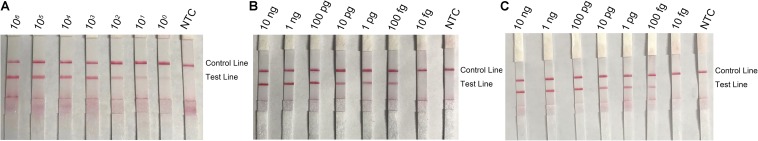
Detection limit of the RPA–LFS system. (A) The image shows the LFS results of RPA amplifications with different amounts of L. monocytogenes culture. The amounts (in CFU) added to the RPA reactions are indicated on top of each strip. (B,C) Images of the LFS results of RPA amplifications with different amounts of L. monocytogenes genomic DNA. The amounts added to the RPA reactions are indicated on top of each strip. In panel C, 10 ng of the genomic DNA of B. cereus was added to the reactions in addition to the L. monocytogenes genomic DNA. The NTC strips are the no-template controls. The reactions were performed at 40°C for 20 min. The positions of the Control and Test lines are indicated on the right of the images.